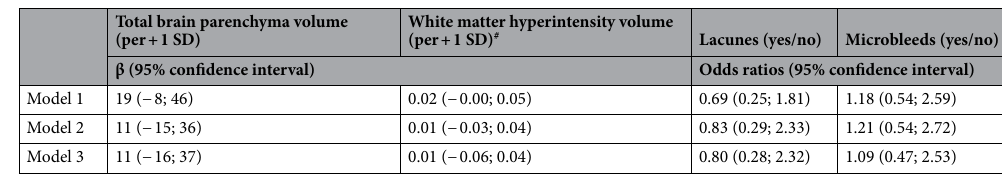
Table 6. Associations between serum N-acetylaspartate levels (lowest quartile vs highest quartile; highest quartile served as reference) and cerebral small vessel disease features. Model 1: unadjusted; Model 2: adjusted for age, sex, education and glucose metabolism status; Model 3: Model 2 + for prior cardiovascular disease, hypertension, smoking and body mass index. Data available in n = 533. # White matter hyperintensity volume was log-transformed.